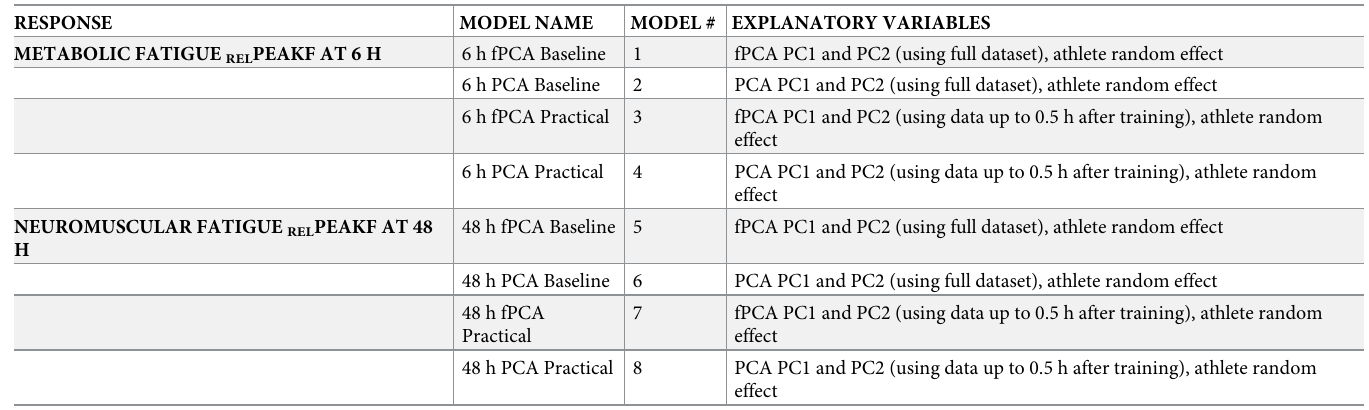
Table 1. Summary of predictive